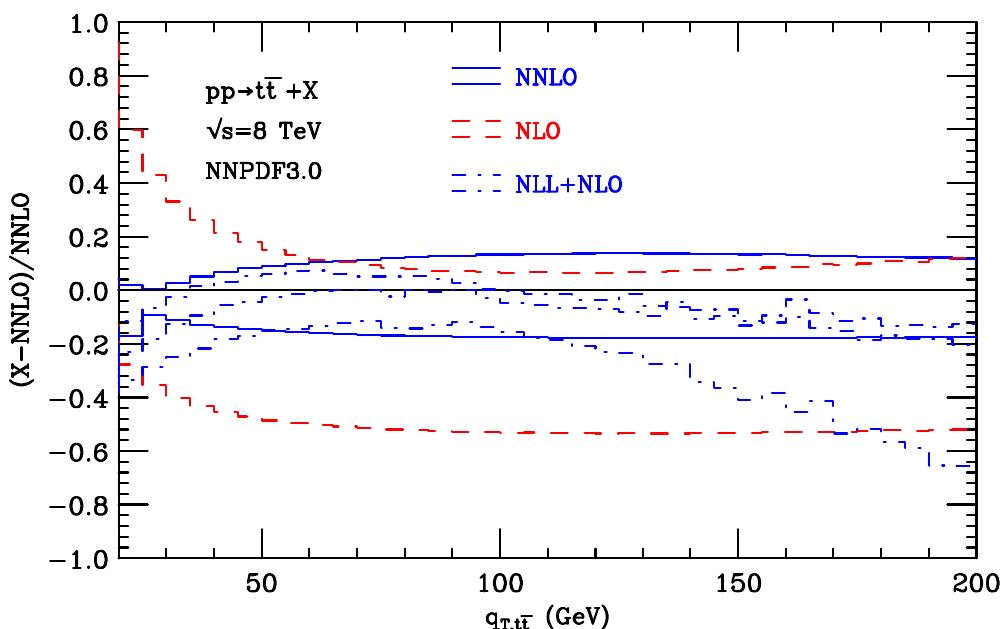
Figure 6. Fractional difference of the scale dependent NLO (red dashed), NNLO (blue solid) and NLL+NLO (blue dot-dashed) results with respect to the NNLO result at µ F = µ R = m t . The results refer to the differential cross section dσ/dq T of t ¯ t pairs at √ s = 8 TeV.